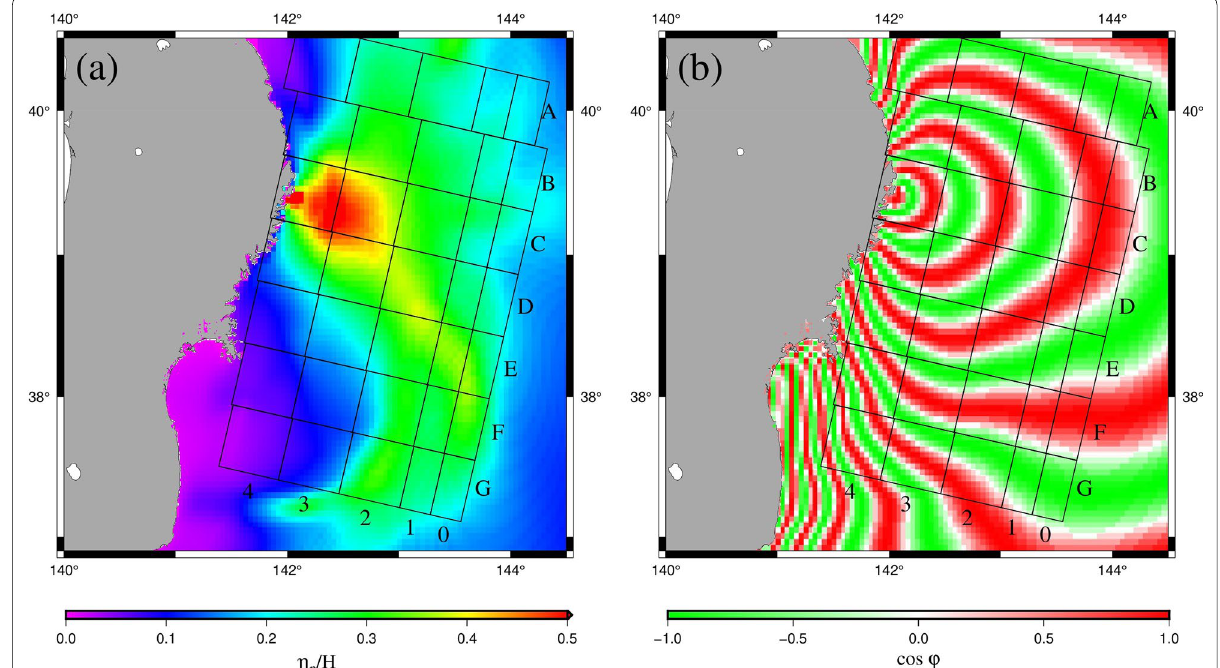
Fig. 5 Distributions of the maximum amplitude in the primary wave ( η p ) and phase ( φ ) for a wave period of 8 min ( a and b